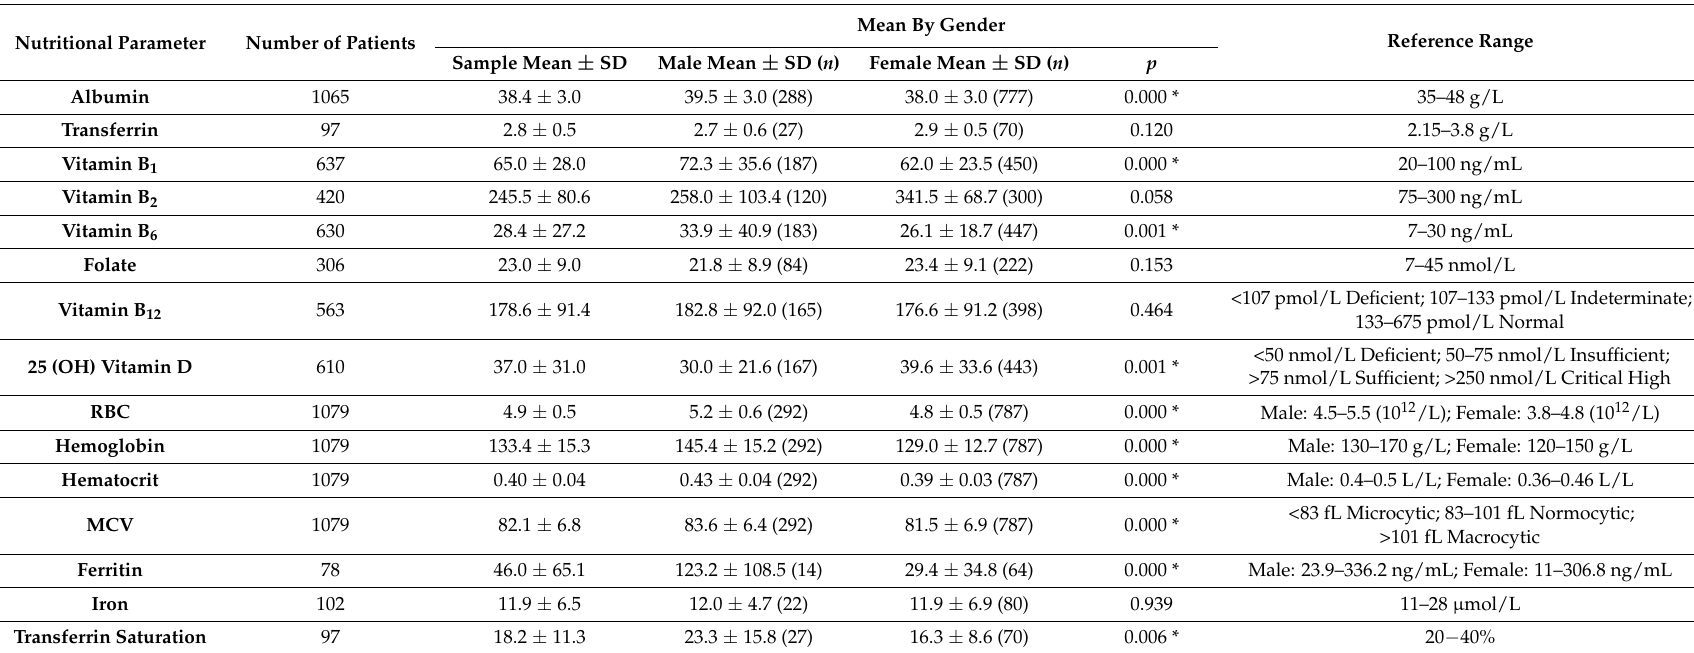
Table 1. Nutrient status of patients pre bariatric